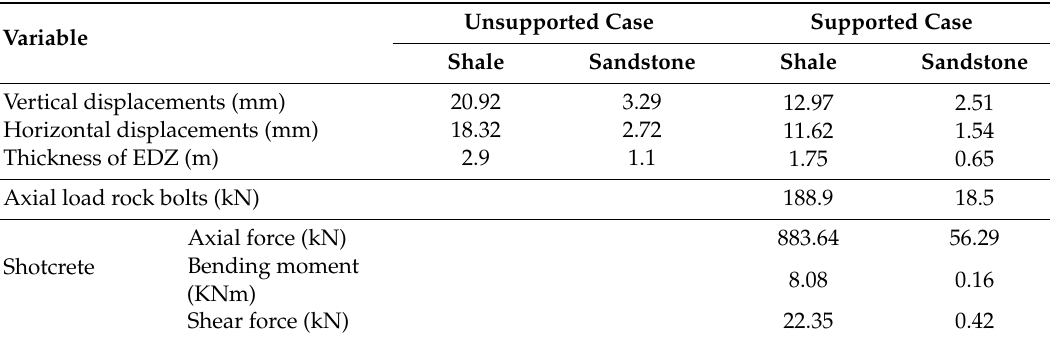
Figure 7. The central tunnel in shale formation: ( a ) rock bolts axial force [N]; ( b ) state of plasticity. Table 7. Numerical simulation results in the central